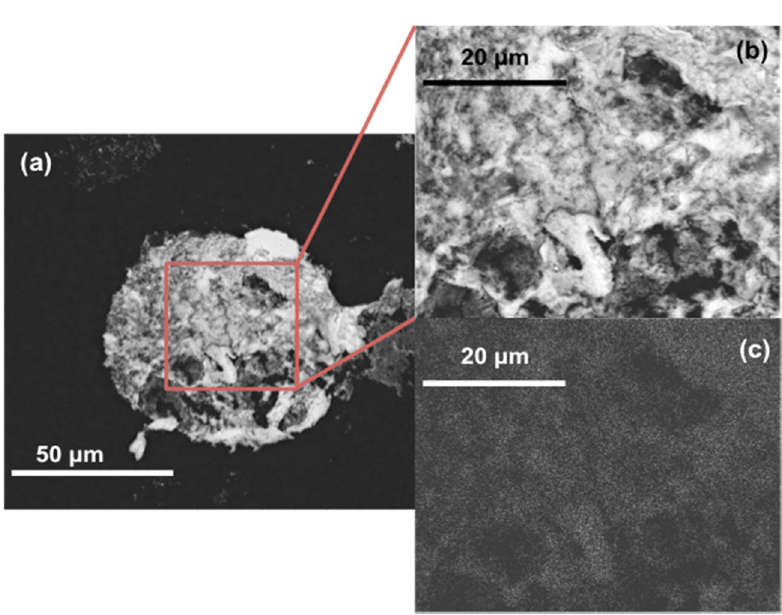
Figure 3. SEM images of a dry tin oxide coated microcapsule target ( a ) and ( b ), and corresponding EDS mapping of elemental tin ( c ). The lighter specks ( c ) correspond to the tin oxide nanoparticles. The images are of a PVA[PSS/PAH] 3 [SnO 2 /PAH] 2 SnO 2 microcapsule with 28% tin content by